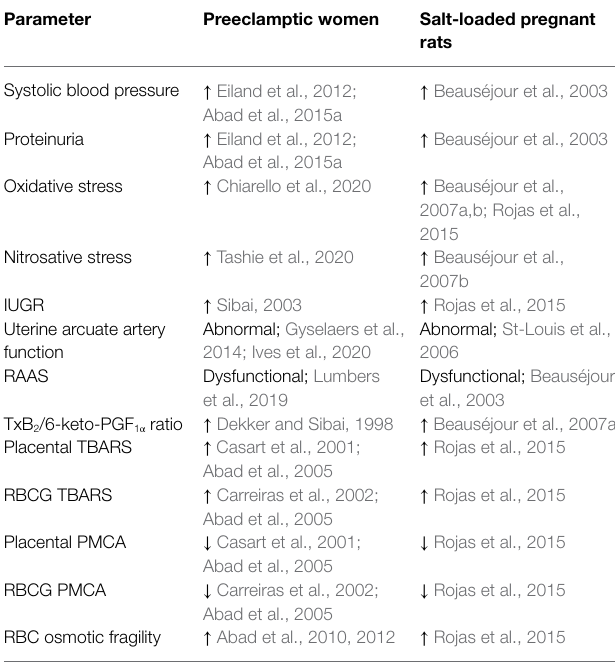
TABLE 1 | Comparison of several parameters between preeclamptic women and salt-loaded pregnant